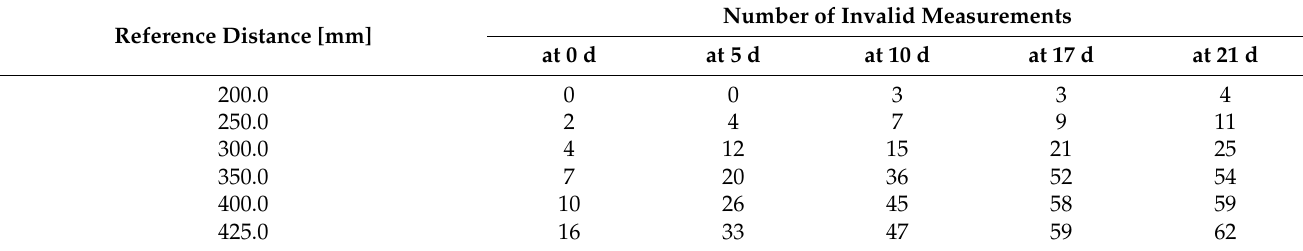
Table A2. Influence of the accelerated aging on the number of invalid measurements (Figure